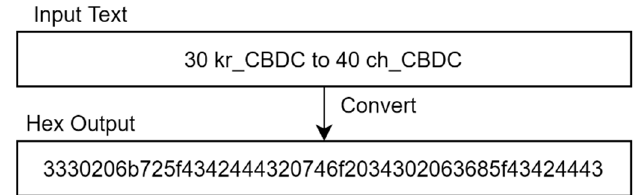
Figure 8. Create account and block in bitcoin.